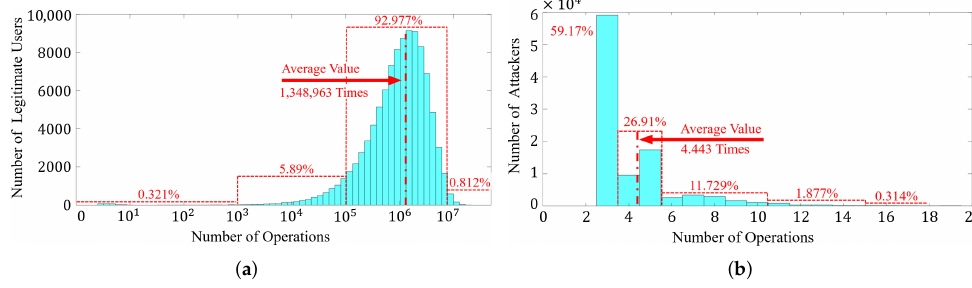
Figure 14. Most attackers are flagged out within six operations, while only a small part of legitimate users are misjudged within 100,000 times of continuous operations. ( a ) Histogram of operable times for legitimate users. ( b ) Histogram of operable times for attackers.